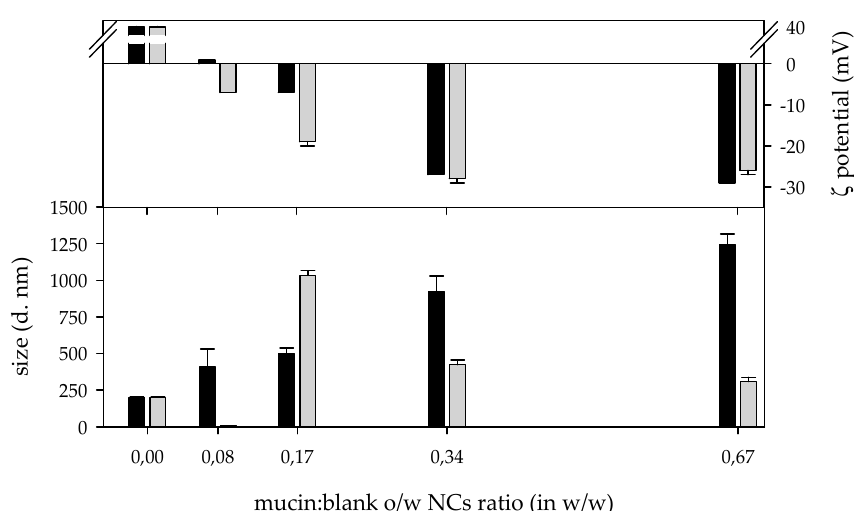
Figure 6. ζ -potential and size (Z-average) of nanocomposites ( n = 3) obtained after the interaction among mucin and blank nanocapsules at different ratios at 0 (black) and 24 h (grey) after the preparation. ◦ After 1 h of incubation at 37 C, those NCOMs prepared at a mucin:B o / w NC ratio of 0.08 ( w / w